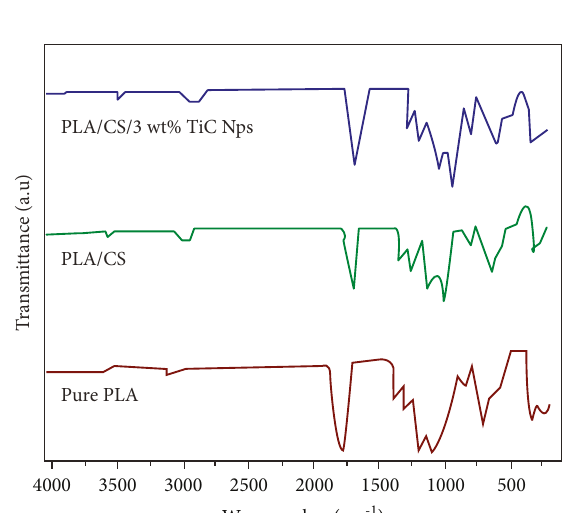
Figure 4: DTG of TiC NPs.